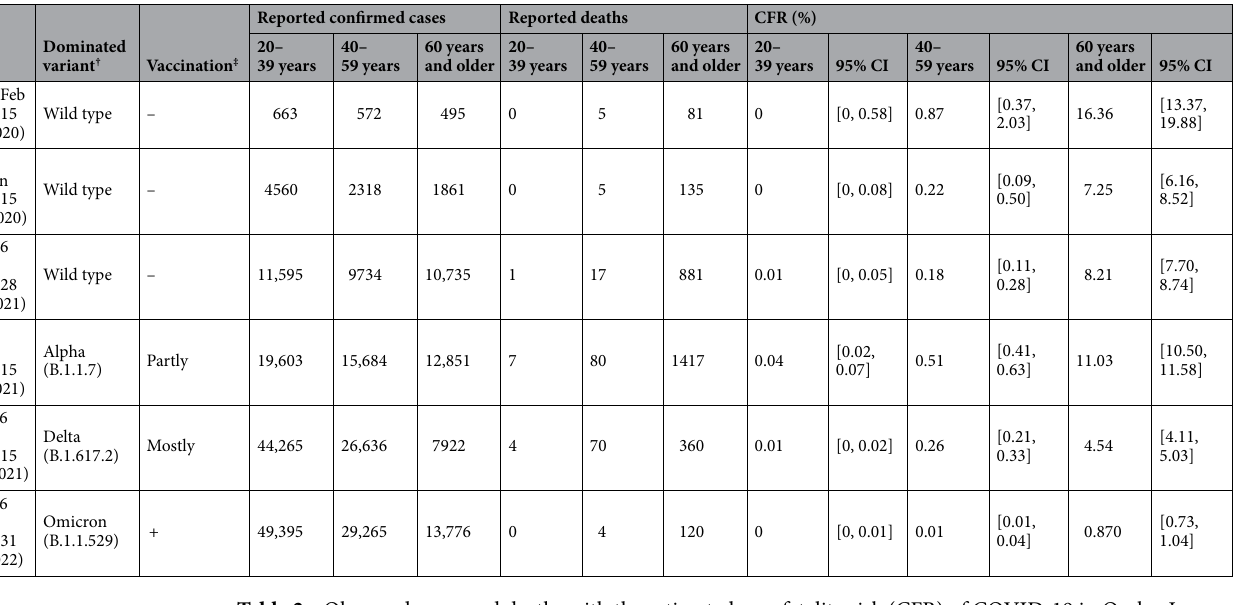
Table 2. Observed cases and deaths with the estimated case fatality risk (CFR) of COVID-19 in Osaka, Japan, 2020–2022. CI confidence interval (using score confidence interval). † The variant of concern that occupied the largest quota in the genome survey during the corresponding wave. ‡ Qualitative description of the progress of vaccination program.